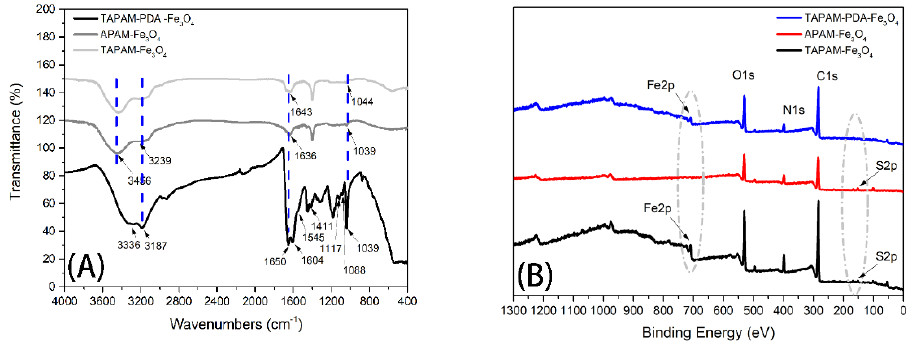
Figure 3. FT-IR ( A ) and XPS ( B ) spectra of TAPAM-PDA-Fe 3 O 4 , APAM-Fe 3 O 4 and TAPAM-Fe 3 O 4 (the dotted lines and dotted circles are corresponding to the peaks mentioned in Section 3.2.1).